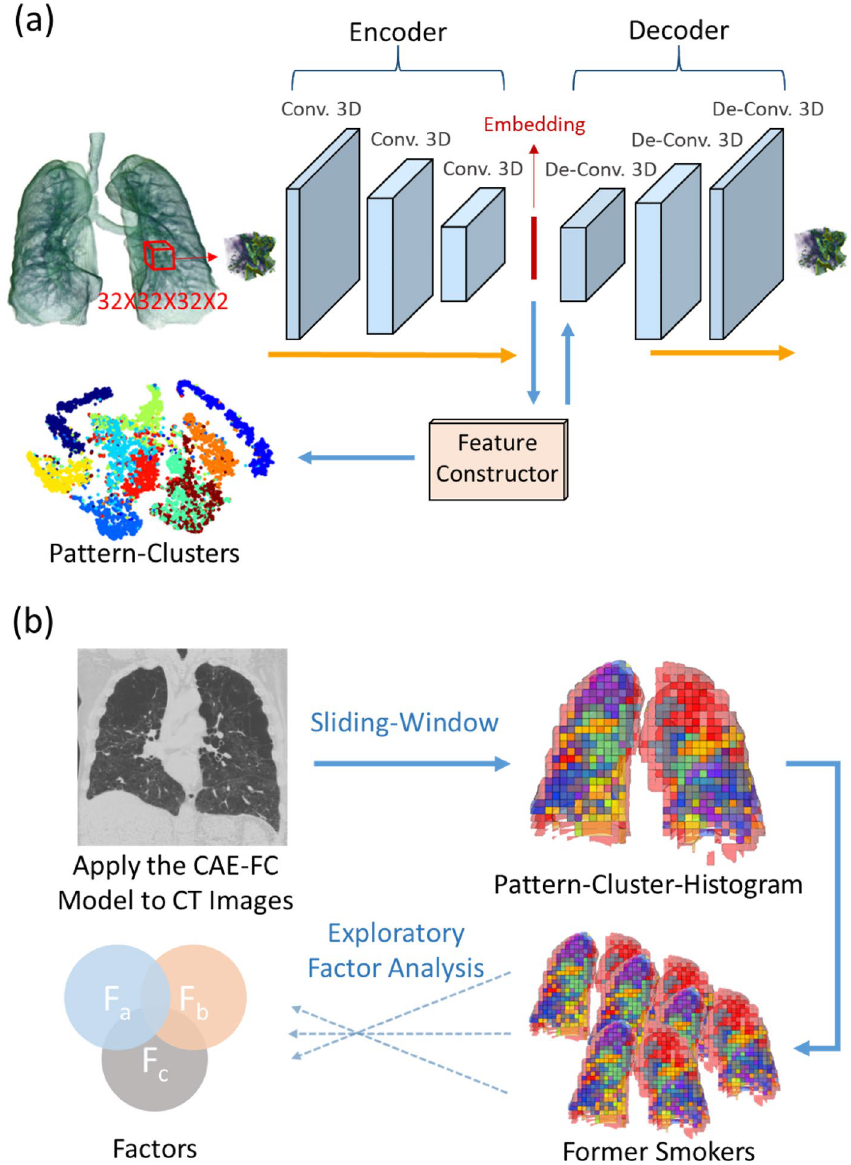
Figure 1. ( a ) 3D ROIs are randomly extracted from the 3D CT lung image and fed into the 3D convolutional autoencoder (CAE) to learn the 1D representations (embedding) of the ROIs. A feature constructor (FC) uses the embedding to generate pattern-clusters. ( b ) The CAE-FC model is applied to the ROIs extracted by the sliding-window technique to classify lung tissue patterns and construct a pattern-cluster-histogram for each subject. Exploratory factor analysis (EFA) is then used to extract the latent traits from the pattern-cluster- histograms of the